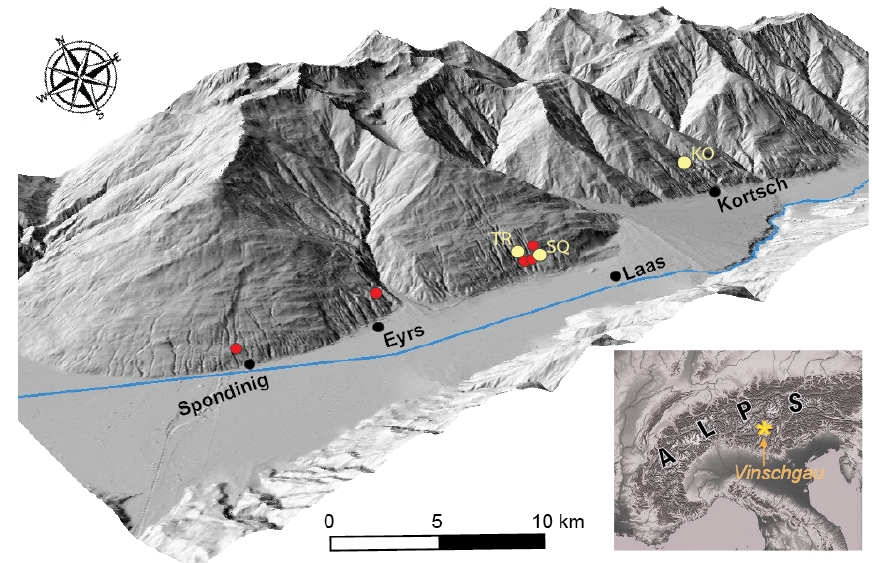
Figure 1. Oblique view of the Vinschgau valley. Red points show the occurrence of vein-filling flowstones in the lower part of the south- facing slope (Sonnenberg). Yellow points mark the three sampling